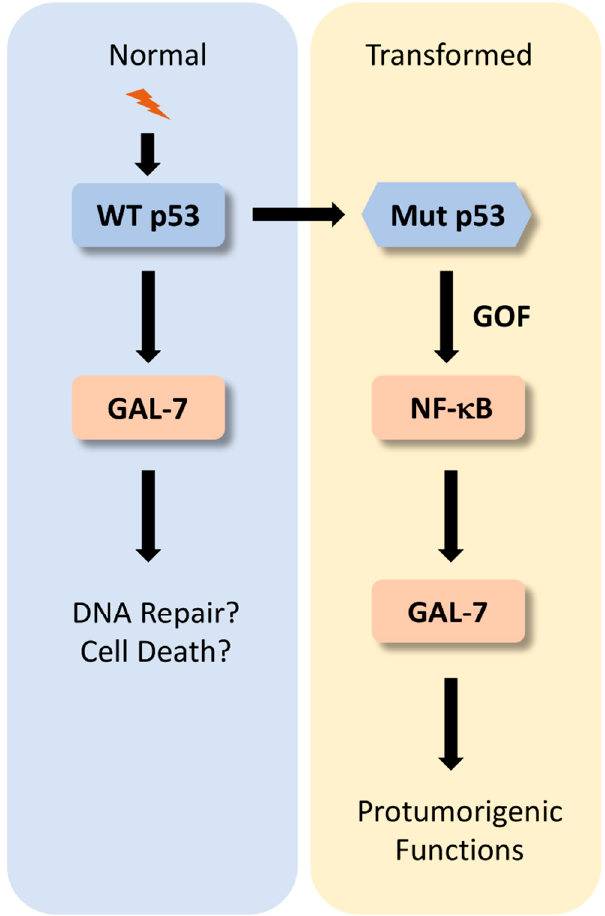
Figure 2. Reconciling the relationship between galectin-7 with wt and mutant p53. In normal cells harboring wt p53 alleles, galectin-7 is induced by de novo expression induced by wt p53 following stress signals. This pathway is also active in some cancer types, such as colon cancer [16]. Expression of nuclear galectin-7 may then regulate the cell cycle and/or DNA repair. In cancer cells with intrinsic resistance to cell death, galectin-7 can be induced by a gain-of-function (GOF) mechanism via mutant p53, shifting the balance towards the pro-tumorigenic role of galectin-7.5. The galectin-7–MMP-9 relationship in cancer.